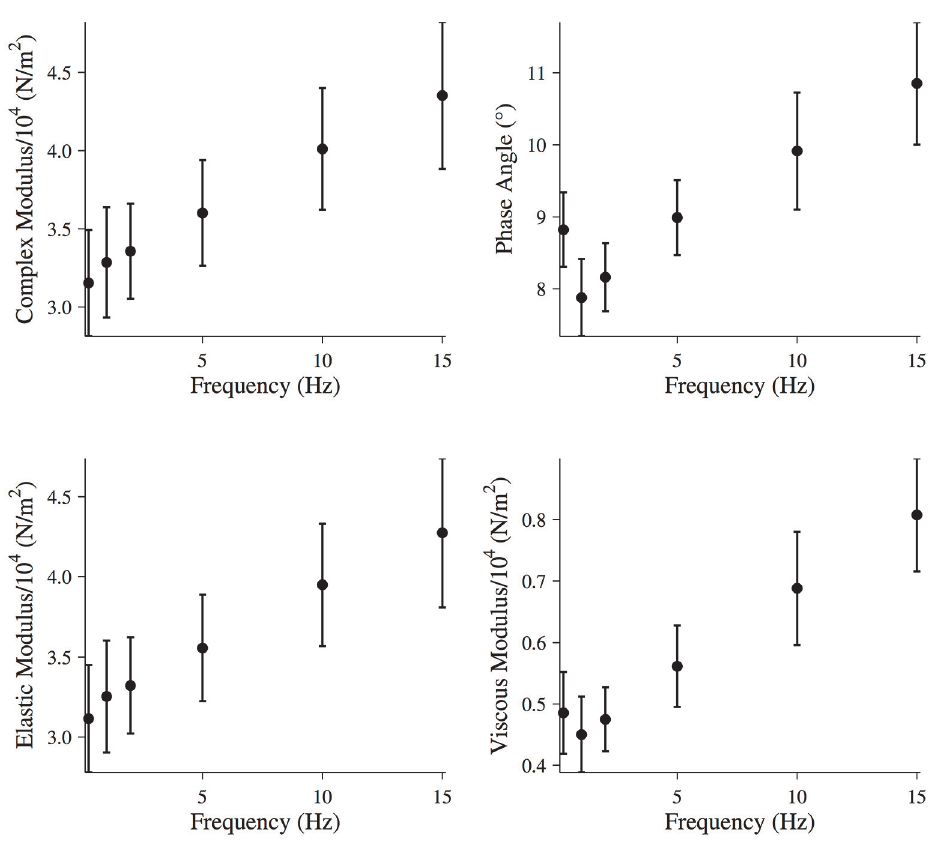
Fig 4. Mechanical properties of relaxed muscle fibers. Magnitude of the complex modulus, phase, elastic modulus, and viscous modulus for relaxed muscle fibers during the final five oscillations of the driven oscillation. All data points are (MEAN ± SEM), and the number of fibers analyzed was N = 6.